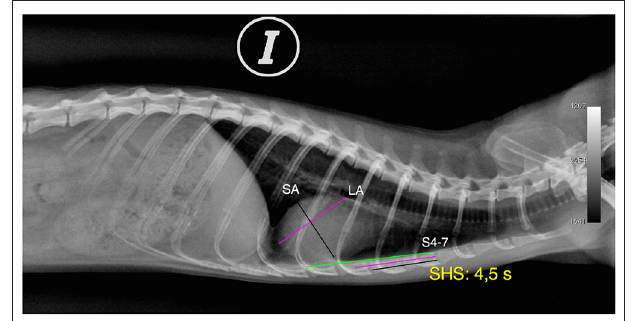
FIGURE 2 | Radiographic image in the left lateral (LL) projection of the normal thorax of a female ferret. X-rays show measurements of the cardiac silhouette. Long axis of the cardiac silhouette (LA), short axis of the cardiac silhouette (SA), sternebral body length from S4 to S7 (S4–7), and sternebral heart scale (SHS) (I,